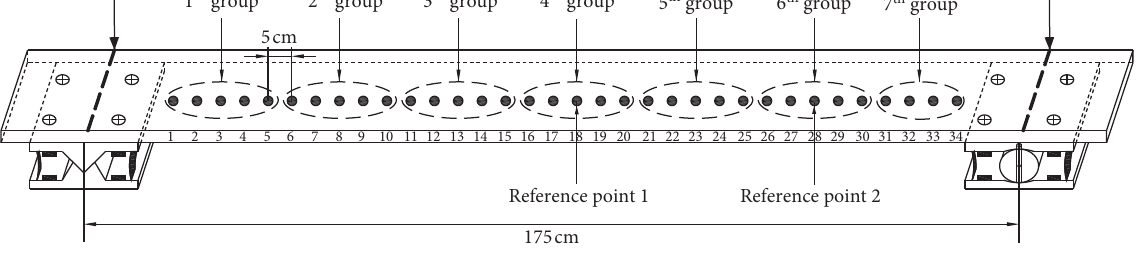
Figure 18: Monitoring point arrangement.